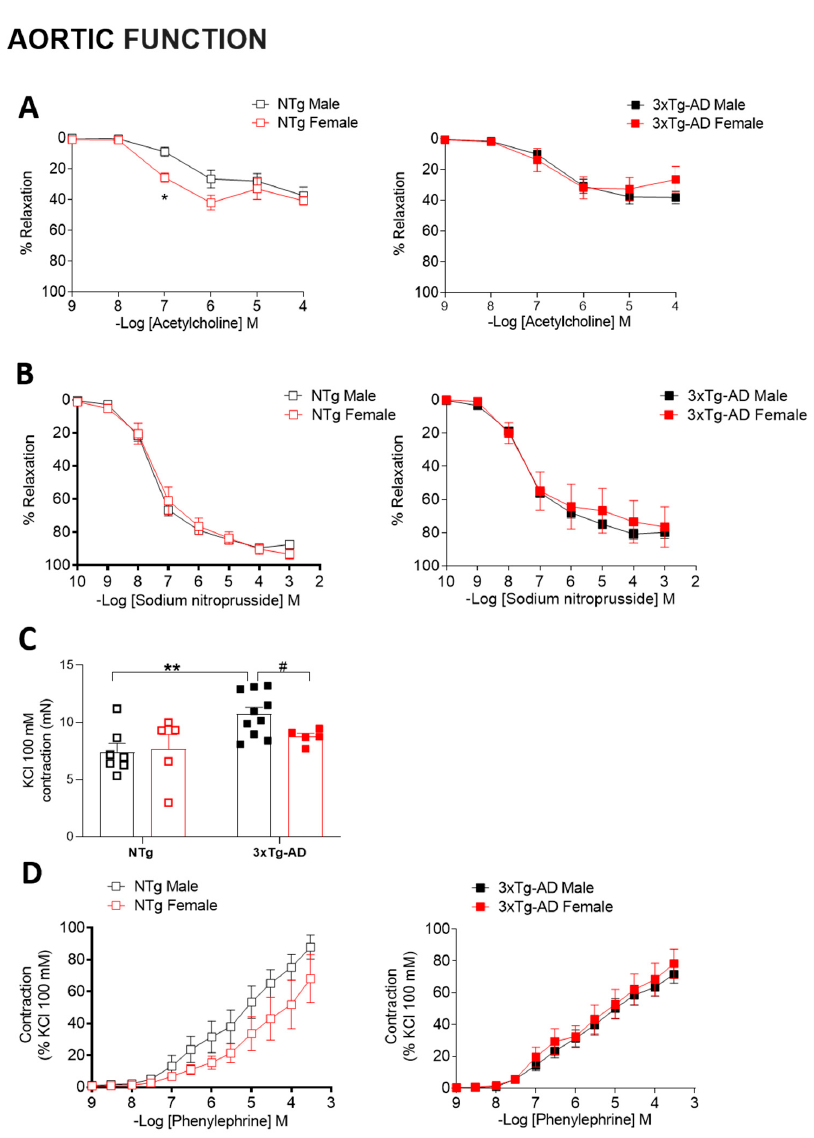
Figure 8. Influence of sex and genotype on aortic function. Concentration-dependent relaxations to acetylcholine ( A ) and sodium nitroprusside ( B ) in thoracic aortas from NTg and 3xTg-AD male and female mice. Contractions to KCL 100 mM ( C ) and concentration-dependent contractions to phenylephrine ( D ). Results are the mean ± SEM from NTg, male n = 7, female n = 5; 3xTg-AD, male n = 10, female n = 5. Data were analyzed by ×-way repeated measures ( A , B , D ) or regular ( C ) two-way ANOVA with Tukey post-test. * p < 0.05, ** p < 0.01, # p < 0.05.